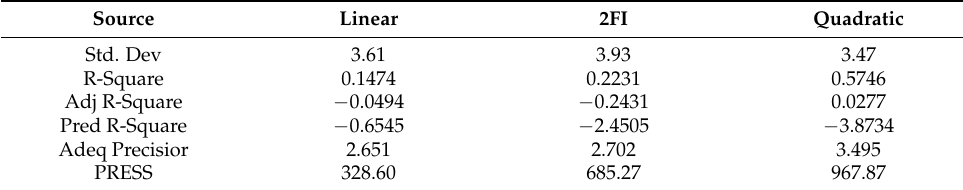
Table 3. Statistical design model of PUM-RSB synthesis.